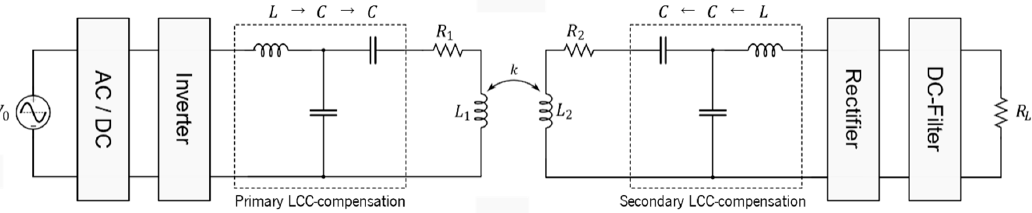
Figure 16. One of the suggested circuit topologies (double-sided LCC (inductor-capacitor-capacitor)) to meet the performance parameters proposed in SAE 2954J.